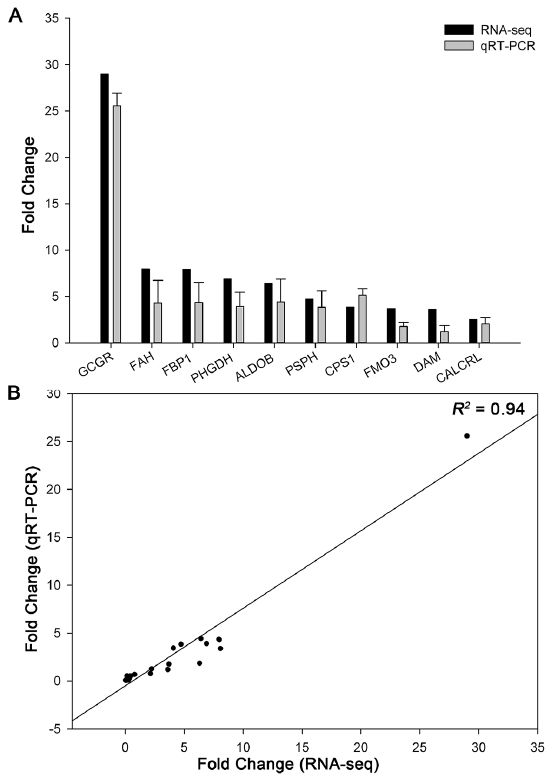
Figure 5. Verification of differently expressed genes by qRT-PCR. ( A ) The expression of 10 genes was validated using qRT-PCR and compared with the expression levels obtained from RNA-seq. The qRT-PCR values were normalized relative to the expression levels of GAPDH in the same cDNA sample. Expression data are presented as expression values of genes in right gonads relative to that in left sample. Data are expressed as the mean ± SD of two biological replicates. ( B ) Correlation of 29 gene expression results obtained from RNA-seq and qRT-PCR.